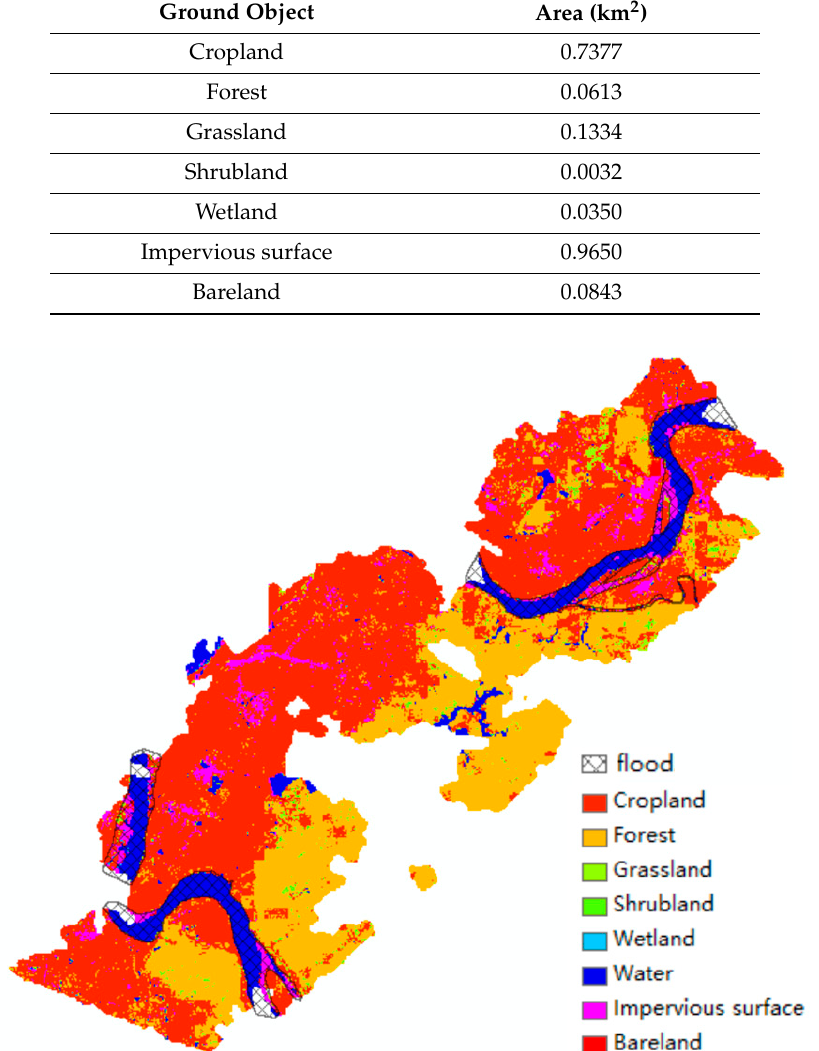
Figure 8. Flood map overlaid on the FROM-GLC 2017 land cover map.